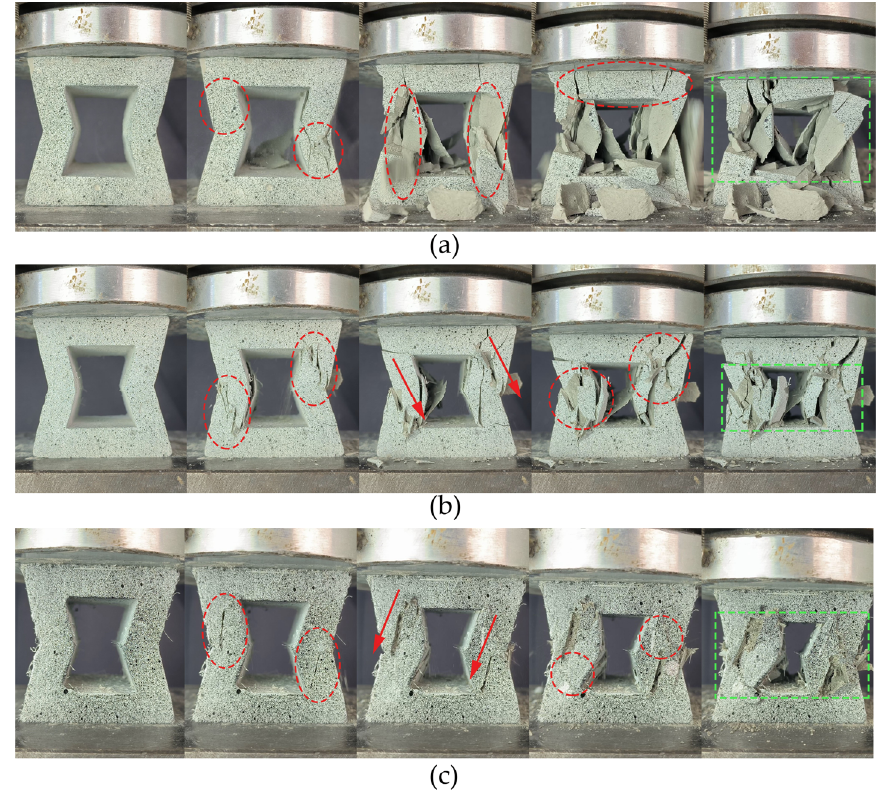
Figure 8. Failure process of different concave hexagonal cell specimens: ( a ) A−0; ( b ) A−0.5; ( c ) A−2.5. For the concave hexagonal unit cell with 0% fiber content, the damage process is shown in Figure 8a. During the compression process, the cell wall first showed an oblique crack on the left and right sides along the concave edge of the hexagon, basically in the